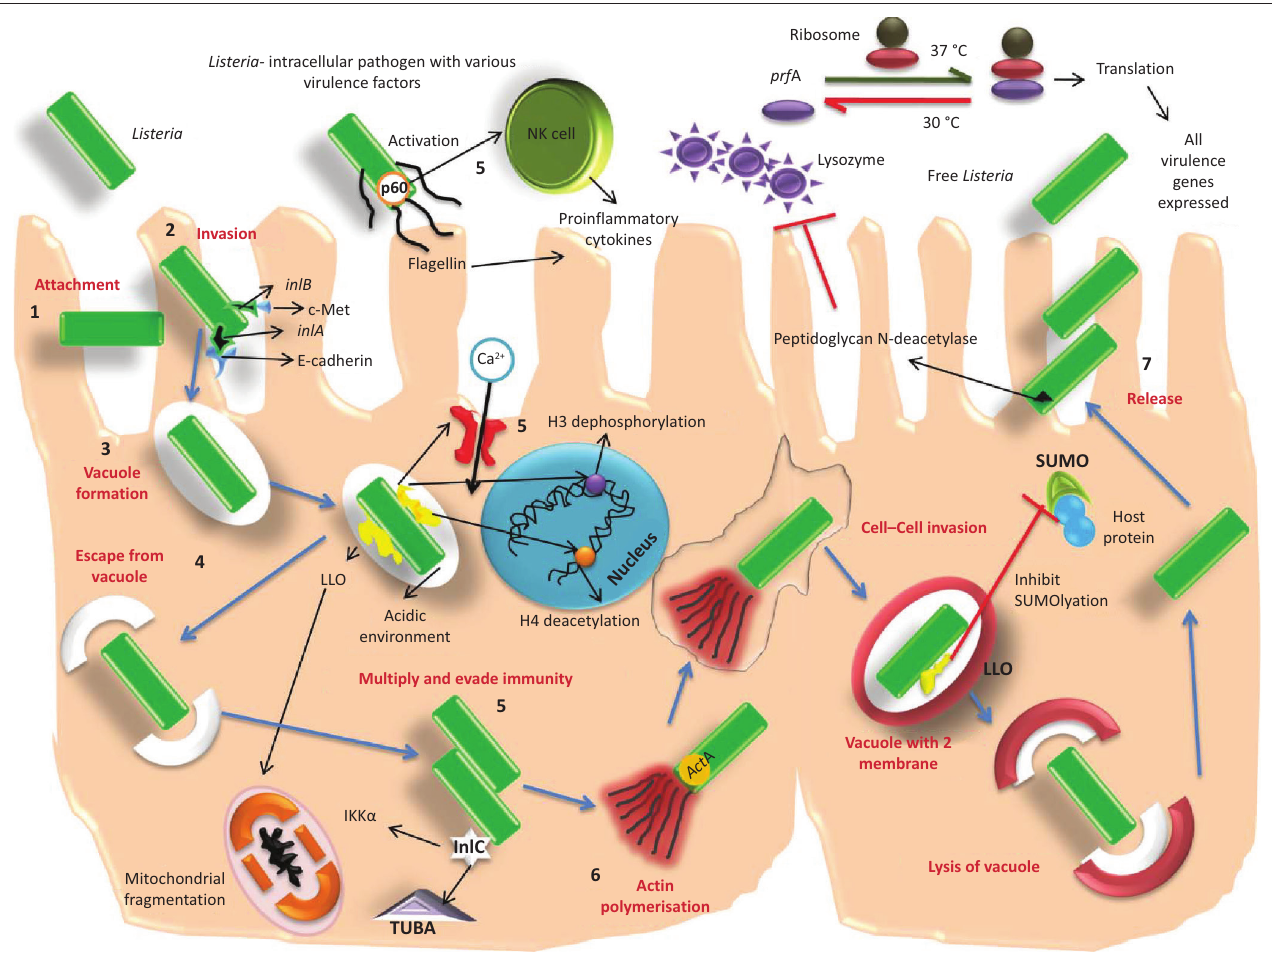
FIGURE 1: Pathogenesis and virulence genes involved in listeriosis infection in human